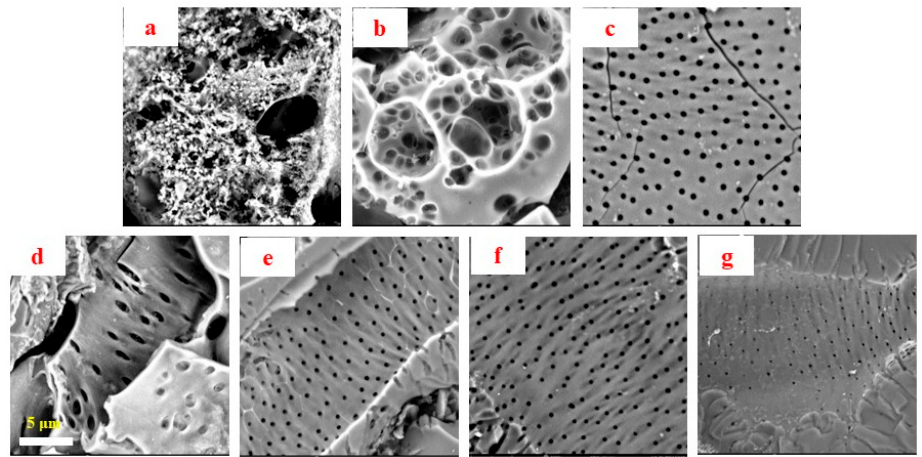
Figure 2. SEM images of activated ( a – g ) Camellia oleifera fruit shell (COS) samples obtained at 250, 350, 450, 550, 650, 750 and 850